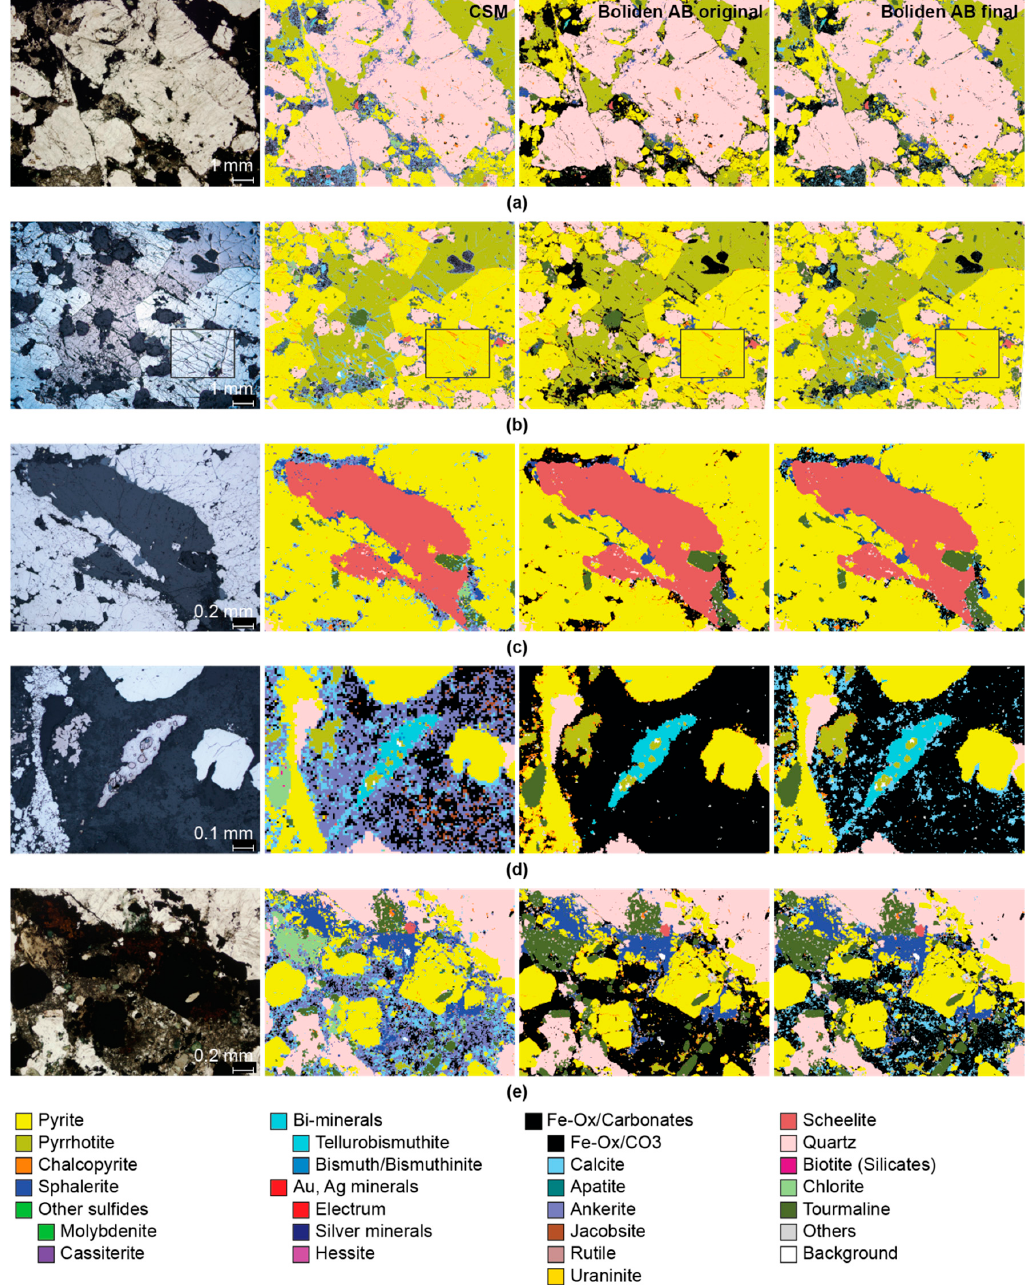
Figure 7. (a)–(e) Optical microscopy images and corresponding areas in the QEMSCAN ® mineral maps of CSM and Boliden AB. In (b), the smaller squares show a magnified image of the underlying area to highlight differences in the micro fracture density between the optical images and the mineral maps. The CSM map includes all the minerals presented in the legend. The original Boliden AB map does not subdivide groups and uses “Silicates” instead of “Biotite”. The final version by Boliden AB uses the same mineral list as CSM but lacks “Ankerite”, “Jacobsite” and subdivision of “Au, Ag minerals”. It includes application of the “boundary phase processor” on chalcopyrite and a single-element entry to the SIP (database) with a 25% intensity threshold for Au.